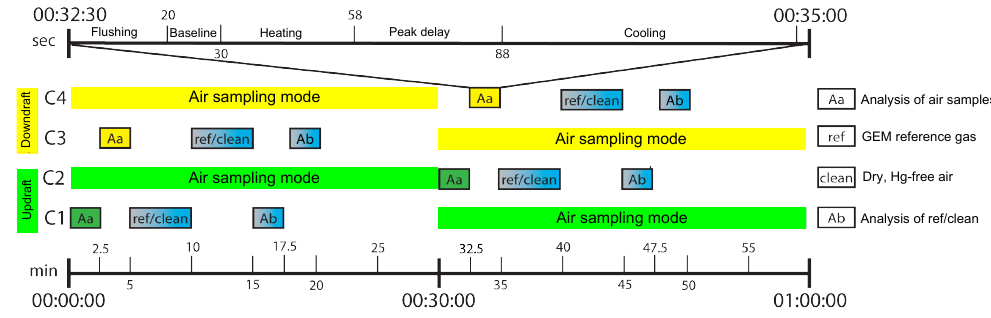
Figure 2. The hourly measuring cycle of the REA system subdivided into the air sampling and GEM analysis procedures (Aa, ref/clean, Ab). At the start of a sequence, cartridge pair C2 and C4 adsorb GEM in the up- and downdraft simultaneously while previously adsorbed GEM from cartridges C1 and C3 is analyzed. During each cycle, eight analysis procedures which last for 2.5min were conducted.